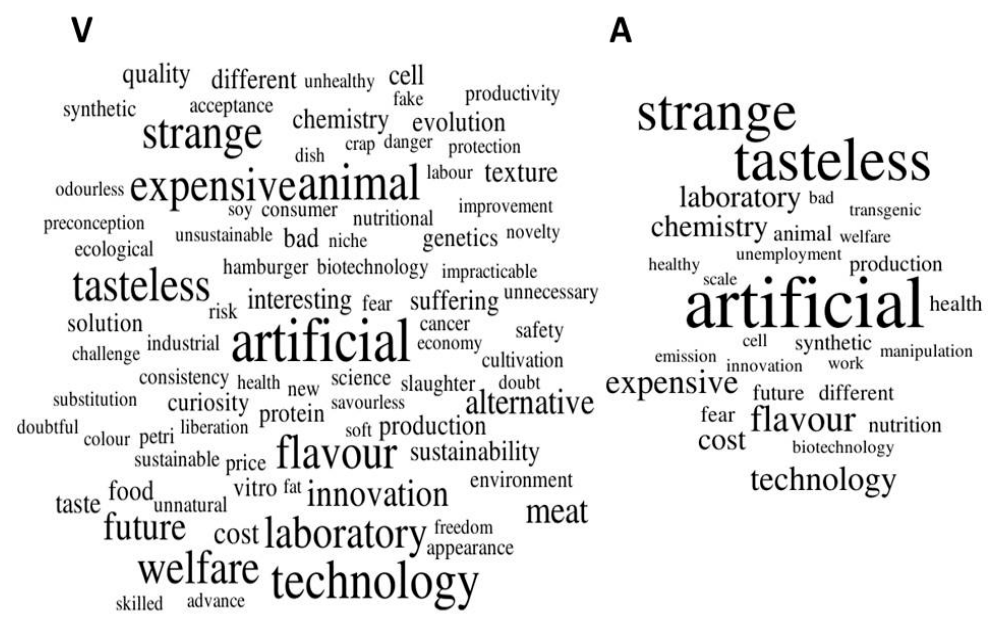
Figure 6. Word clouds composed by words which appeared two or more times in answer to the question “ What comes to your mind when you think of cell-based meat? ”, according to 209 Brazilian veterinarians (V) and 63 animal scientists (A) in a questionnaire. and 63 animal scientists (A) in a